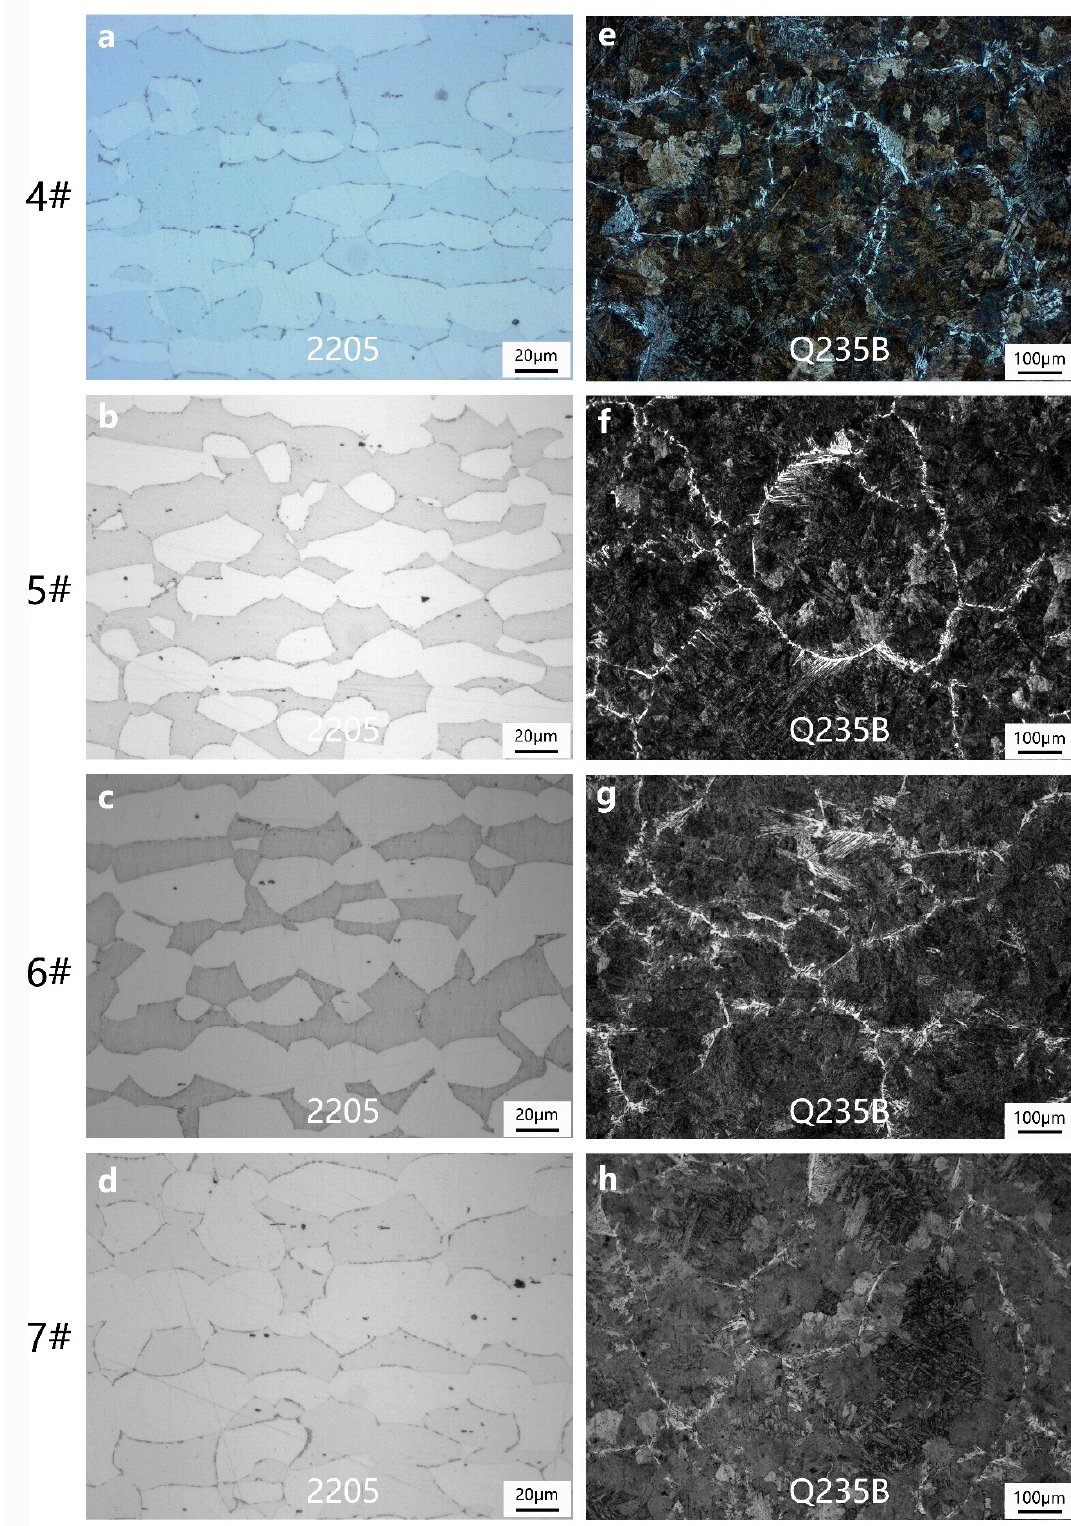
Figure 4. Microstructure of 2205 stainless-steel and Q235B low-carbon steel after di ff erent insulation times: ( a , e )1 h, ( b , f ) 2 h, ( c , g ) 3 h, ( d , h ) 4